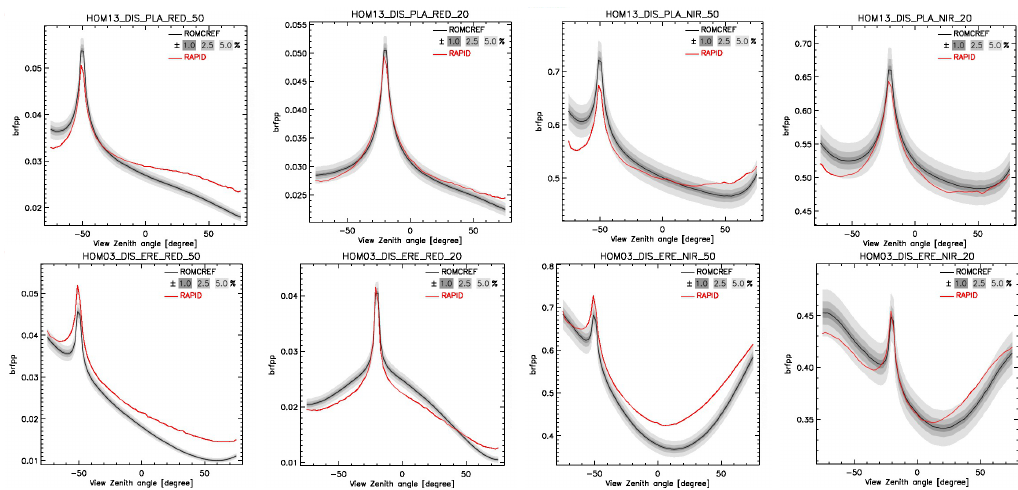
Figure 8. Comparisons of HOM13 (first row) and HOM03 (second row) BRF results in the principal plane (brfpp) with the reference data from the RAMI online checker (ROMCREF). In the subtitles, 20 and 50 are the solar zenith angles. Remote Sens. 2018 , 10 , x FOR PEER REVIEW